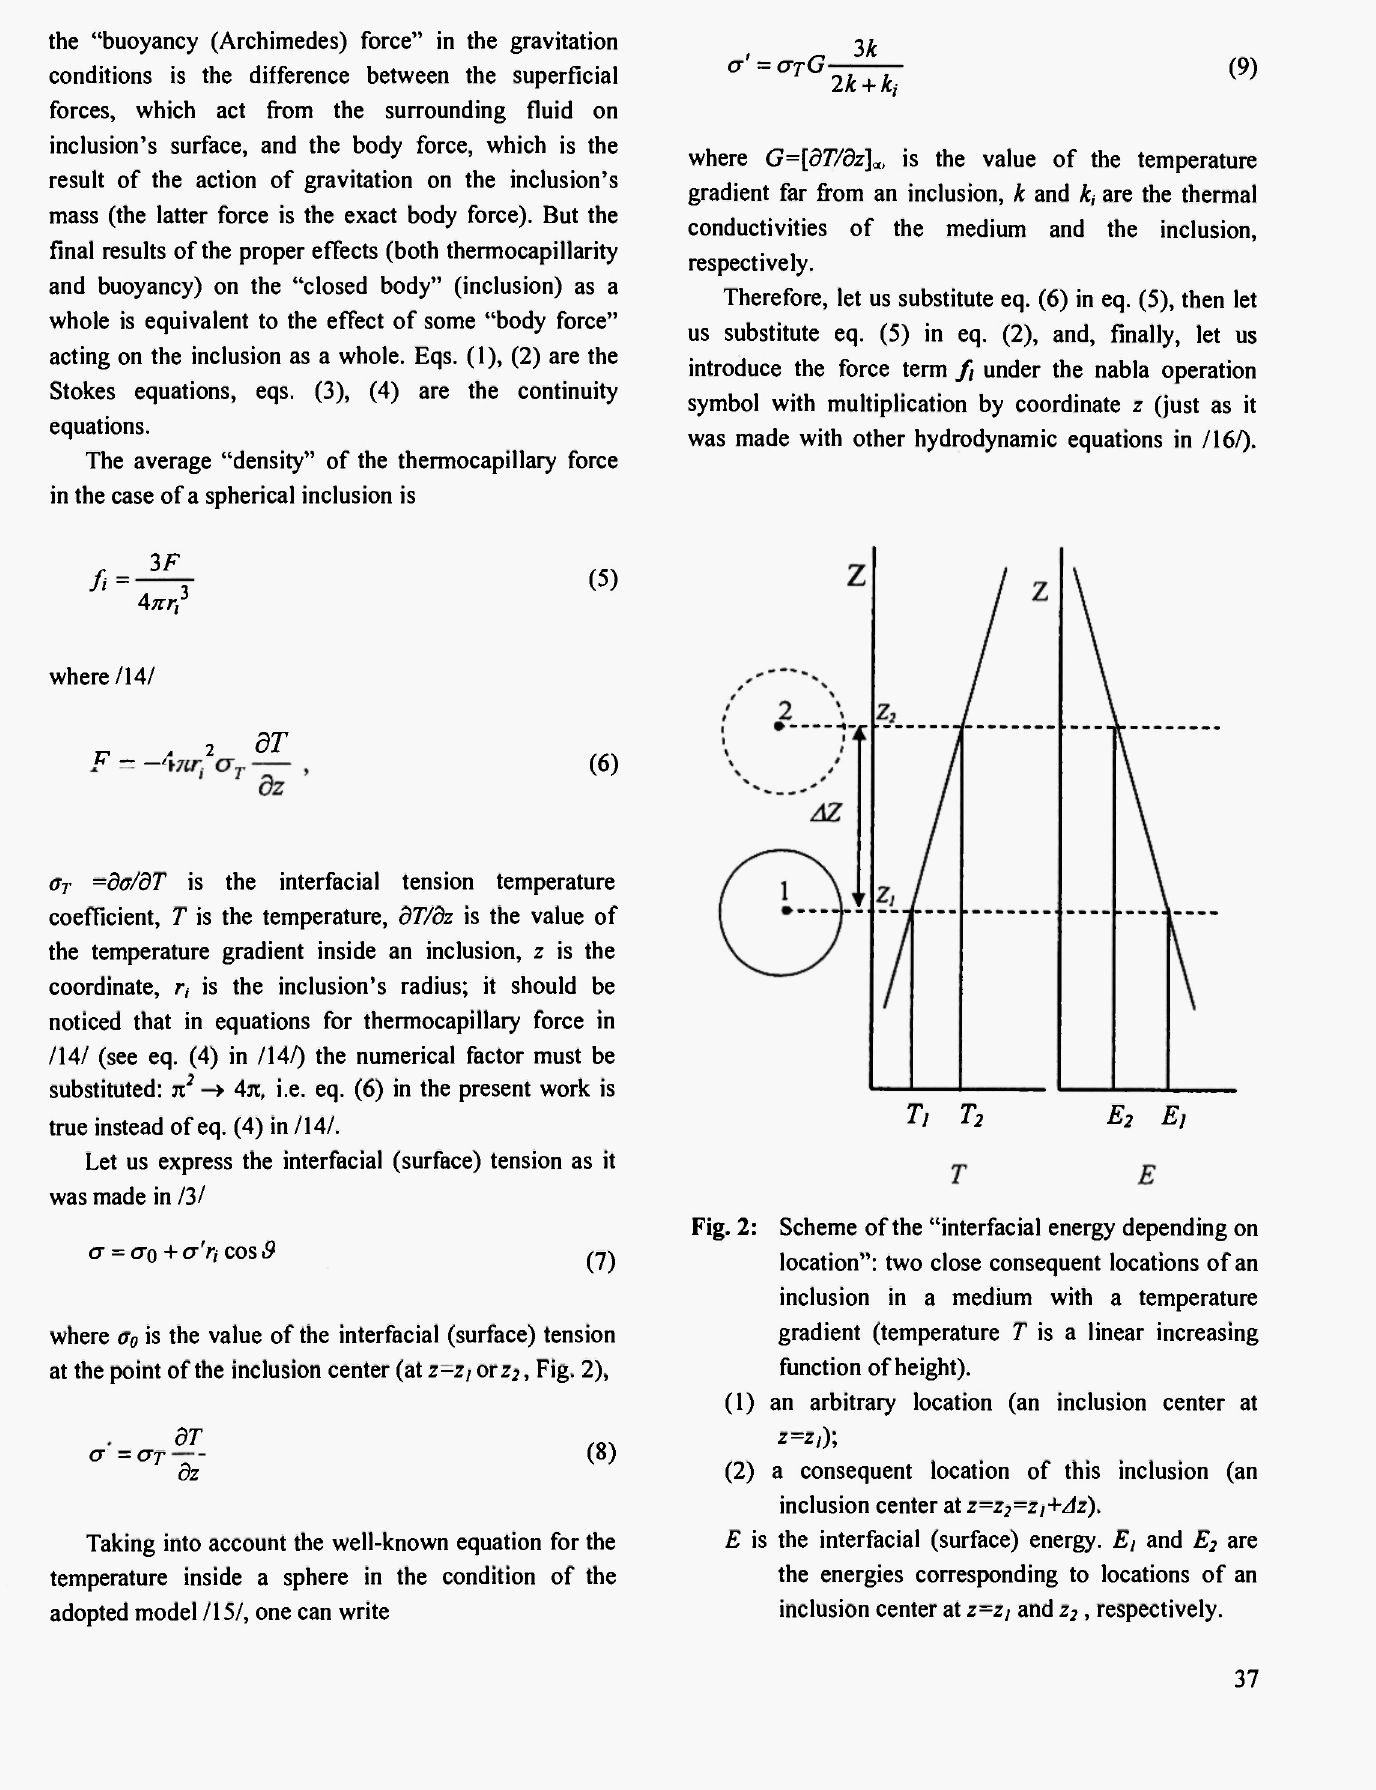
Fig. 2: Scheme of the "interfacial energy depending on location": two close consequent locations of an inclusion in a medium with a temperature gradient (temperature Τ is a linear increasing function of